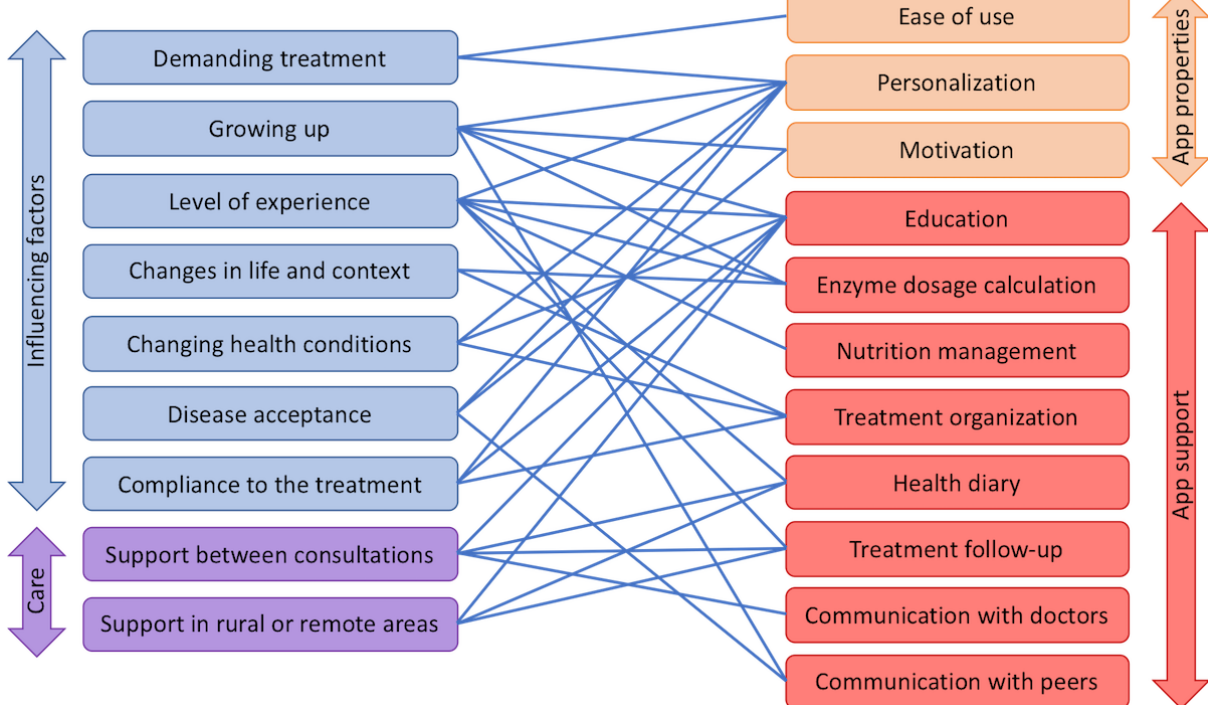
Figure 2. Overview of relevant app properties and features and relations to influencing